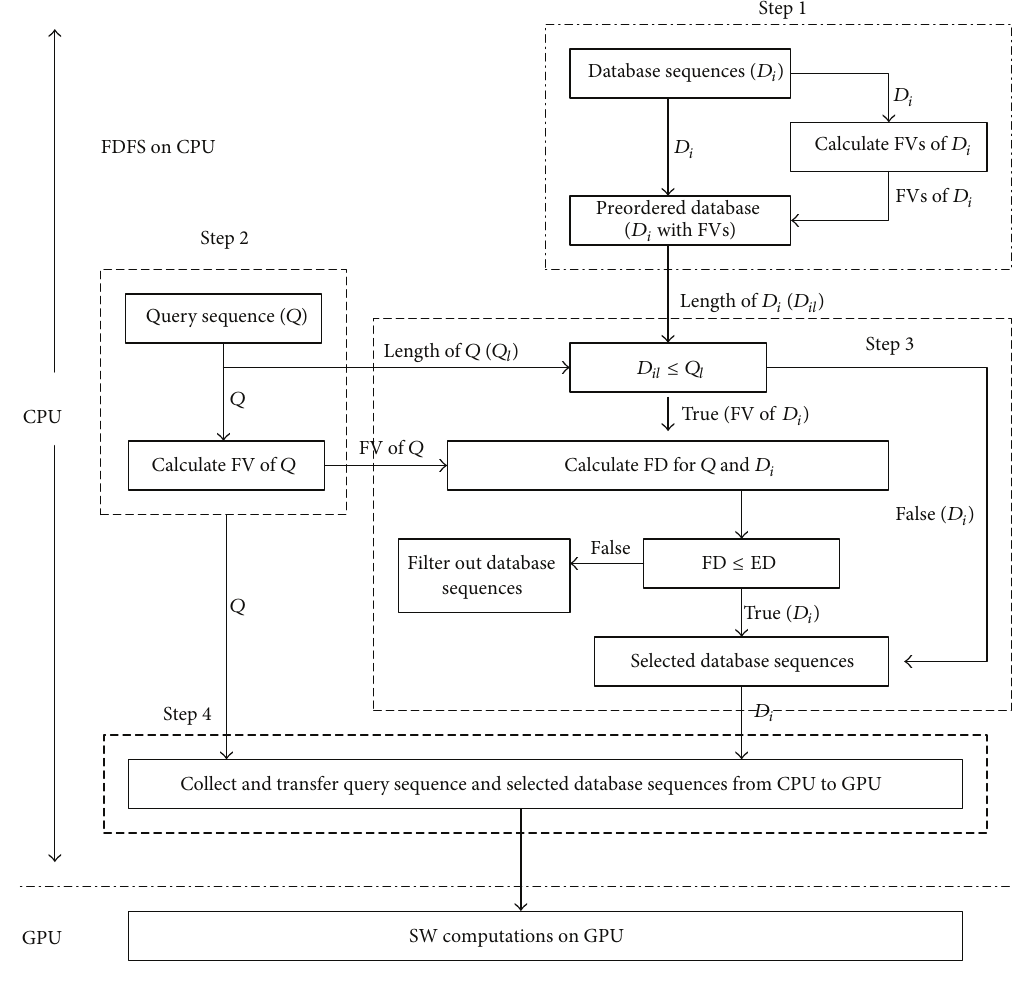
Figure 2: The flowchart of